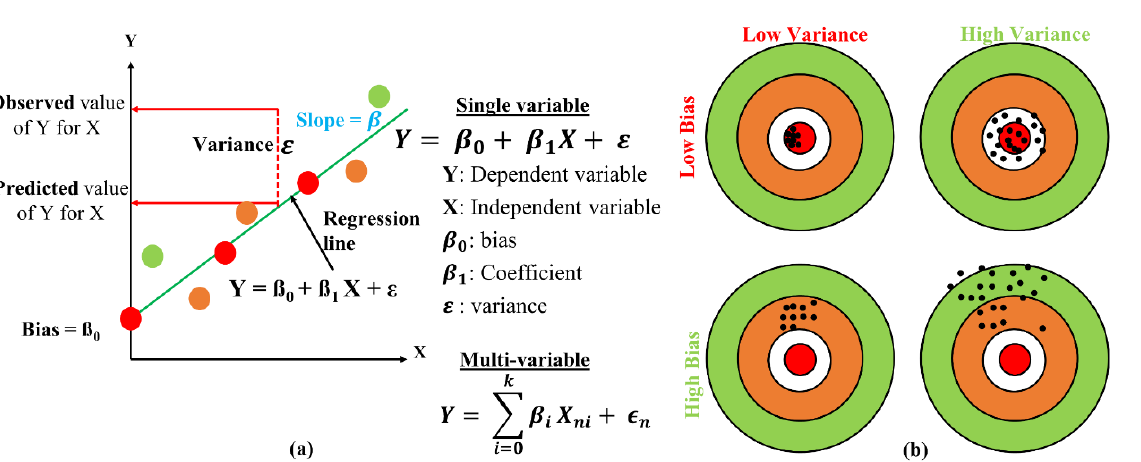
Figure 3. Sigmoid function to model logistic regression ML model. The algorithmic flow to model logistic regression is summarized as follows: 1: Start with random training weights: 𝒘 𝟏 , 𝒘 𝟐 , … , 𝒘 𝒏 , 𝒃 2: for every point ( 𝒙 𝟏 , 𝒙 𝟐 , … , 𝒙 𝒏 ): do 3: